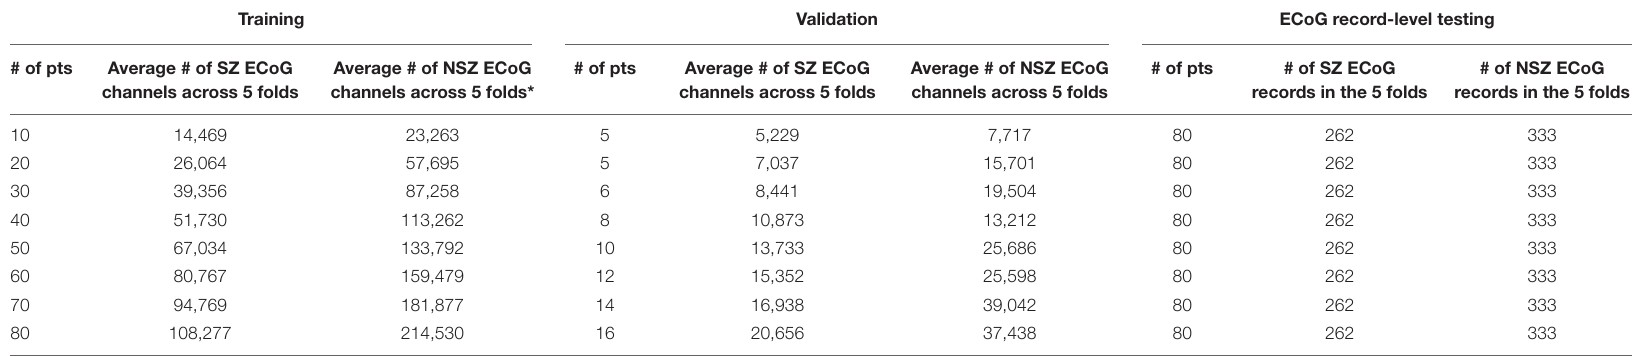
The averages are computed across the 5 folds for each patient-level split. Numbers of training and validation ECoG channels in each fold for each patient-level split is shown in Supplementary Table 2. ECoG = electrocorticographic; NSZ = non-seizure; pts = patients; SZ = seizure. Shown here is the total number of non-seizure ECoG channels available in the training dataset. Note that the non-seizure ECoG channels were randomly downsampled to match the number of seizure ECoG channels to create balanced 50/50 class splits for